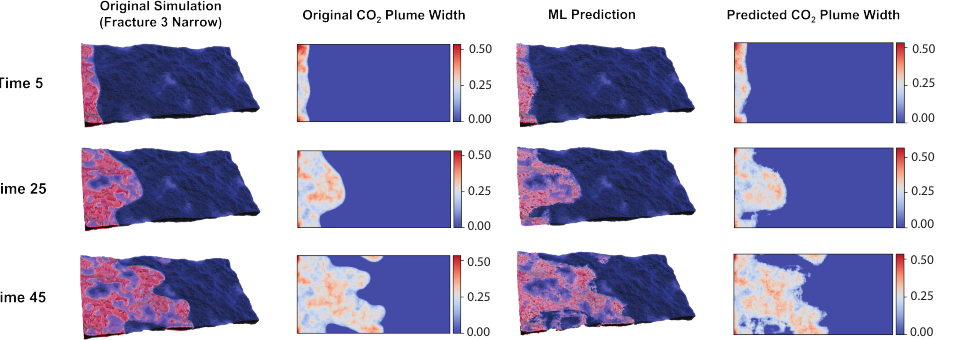
Figure 7. Results of the ML prediction in Fracture 3s for timesteps 5k, 25k, and 45k. Average CO 2 saturation accuracy across all timesteps is